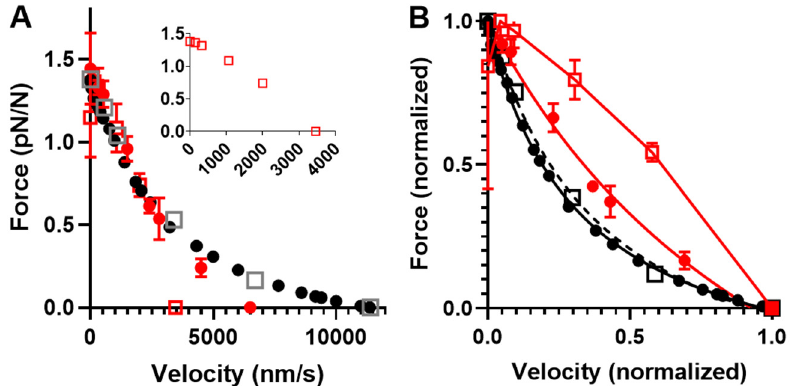
Figure 7. Velocity–force data simulated using differential equations and Monte Carlo approach for ensembles of different sizes . ( A ). Force vs. velocity based on solution of differential equations (Materials and Methods) in the state probabilities (black-filled circles; same as similar symbols in Figure 6) and Monte Carlo simulations assuming N = 3000 (open grey squares), N = 33–39 (filled red circles; mean ± 95% CI), and N = 16–19 (open red squares). Monte Carlo simulation data for N = 3000 based on 1 simulation run, whereas simulations for N = 16–19 and N=33–39 are based on 4 simulation runs per point except for isometric force (velocity= 0 nm/s), which is based on 28 simulation runs ( N = 16–19) and 30 runs ( N = 33–39). Inset: Data for N = 16–19 shown without error bars and assuming that the point for isometric contraction is identical to that at large N (consistent with overlapping 95% CI and data in Figure S1). ( B ). Data in A replotted after normalization of force and velocity to F 0 and V 0 , respectively. Same color and symbol coding as in A. All data sets, except Monte Carlo simulation data for N = 16–19, fitted by Hill’s hyperbola (Equation (14)). Data points for N = 16–19 connected by lines for clarity. Note, virtually identical FV relationships (both in absolute and relative terms) for large ensembles whether data obtained by Monte Carlo simulations or solution of differential equations. Note further that the simulated FV relationship becomes less curved for low N , with loss of the hyperbolic shape for N = 16–19.